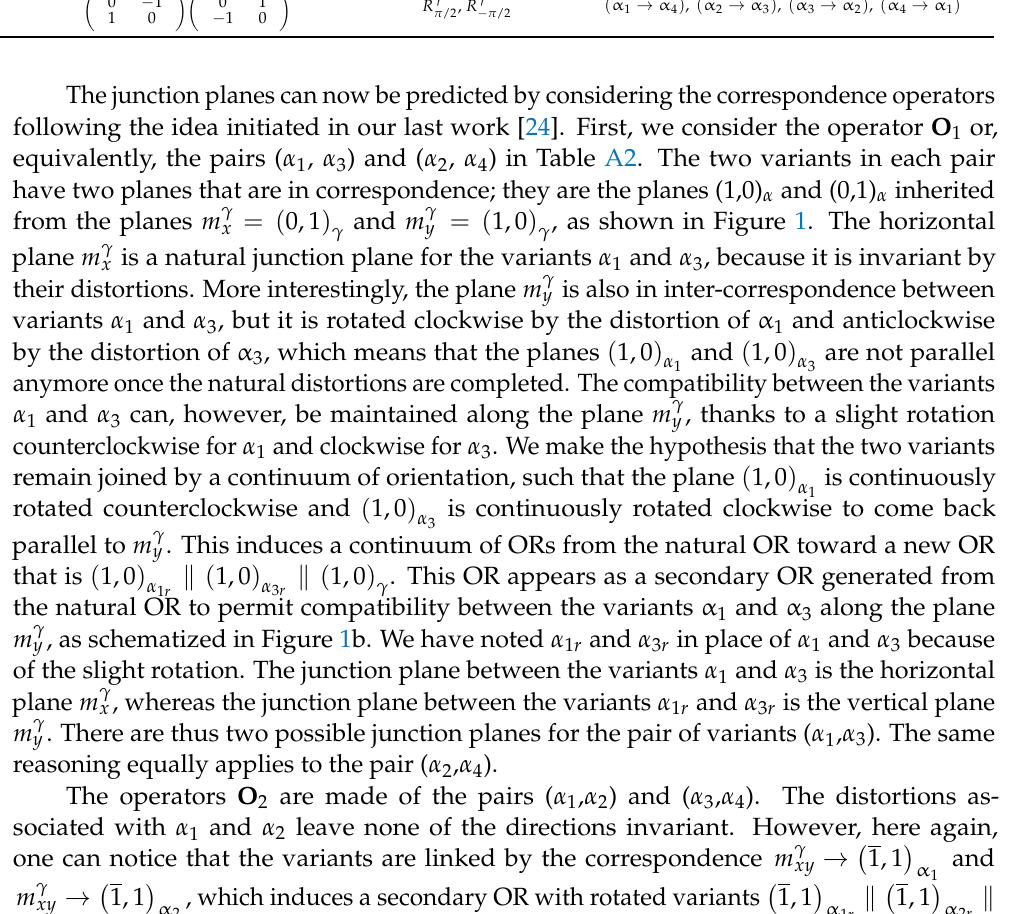
Table A2. Operators O i between α martensite parallelograms. The disorientations are the sec- ond column. The other columns give the double cosets of γ austenite symmetry matrices, with their corresponding geometrical elements, and their set of arrows from one variant (the source) to another variant (the target). In this example, the variants do not depend on the relation C , T or F : 𝐎 (cid:3036) = ℍ (cid:3004)(cid:3082) 𝑔 (cid:3036)(cid:3082) ℍ (cid:3004)(cid:3082) = ℍ (cid:3021)(cid:3082) 𝑔 (cid:3036)(cid:3082) ℍ (cid:3021)(cid:3082) = ℍ (cid:3007)(cid:3082) 𝑔 (cid:3036)(cid:3082) ℍ (cid:3007)(cid:3082) . With Their Disorient. between Operators as Set of Equivalent